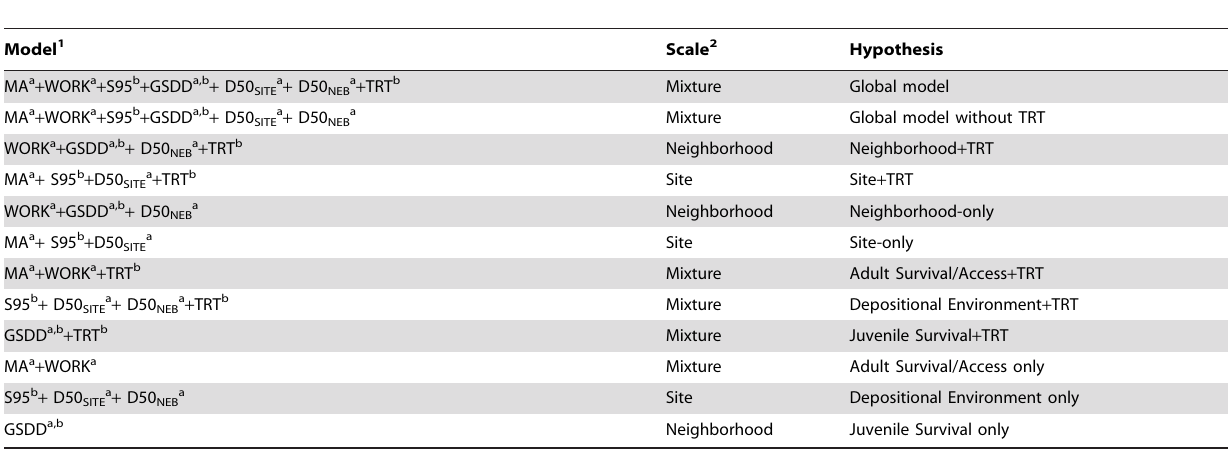
Table 1. Candidate hurdle count regression models used to estimate occurrence and abundance of steelhead redds in the John Day River basin, Oregon.